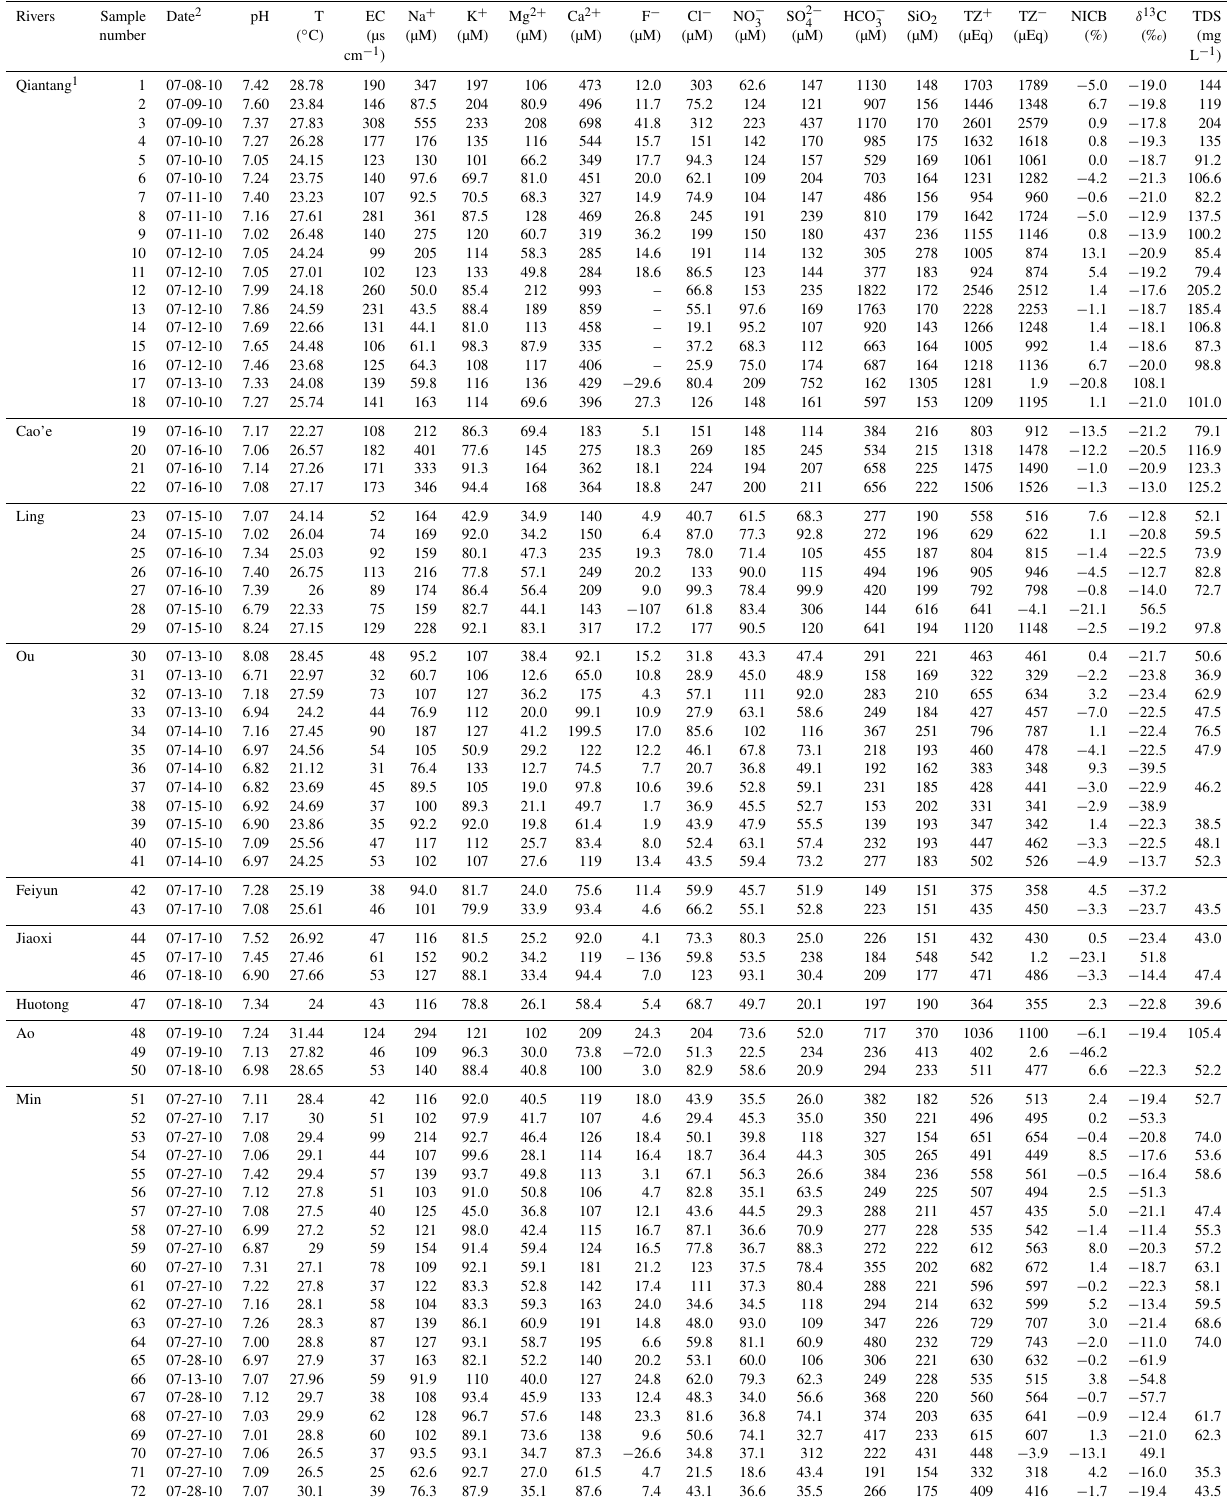
Table 1. Chemical and carbon isotopic compositions of river water in the Southeast Coastal River Basin (SECRB) of China.